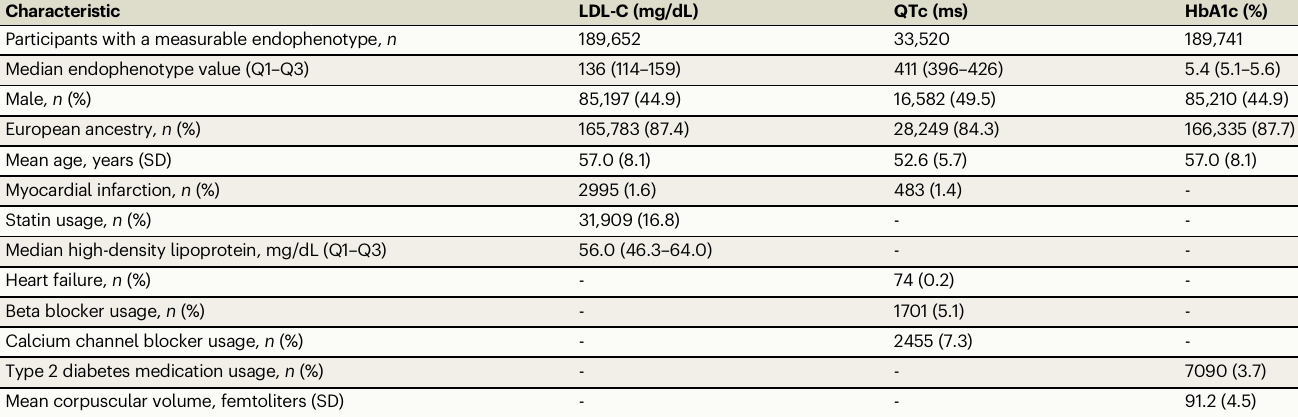
Table 1 | Baseline cohort characteristics by endophenotype in the UK Biobank